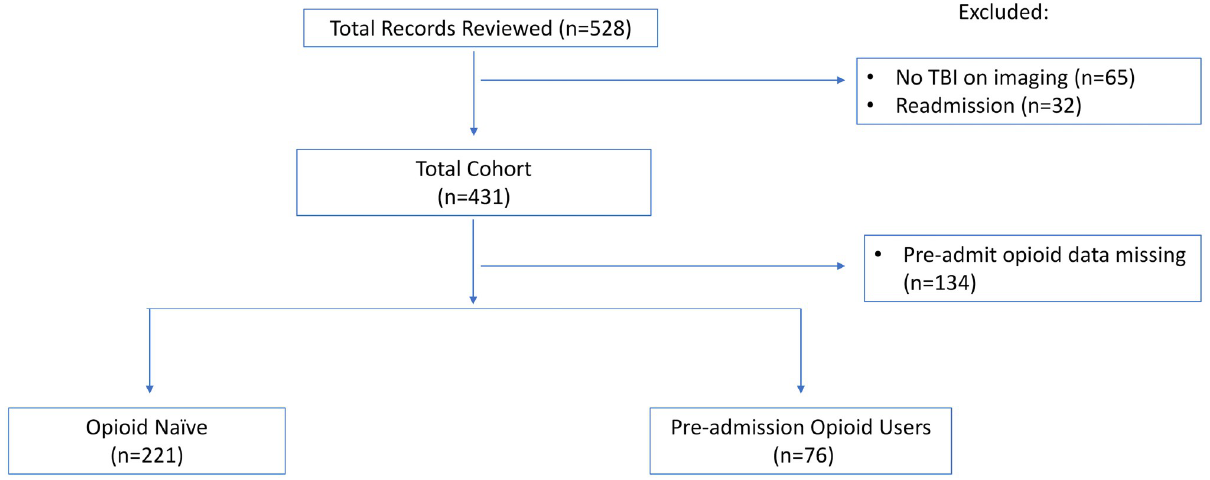
Fig 1. Consolidated standards of Reporting trials (CONSORT)